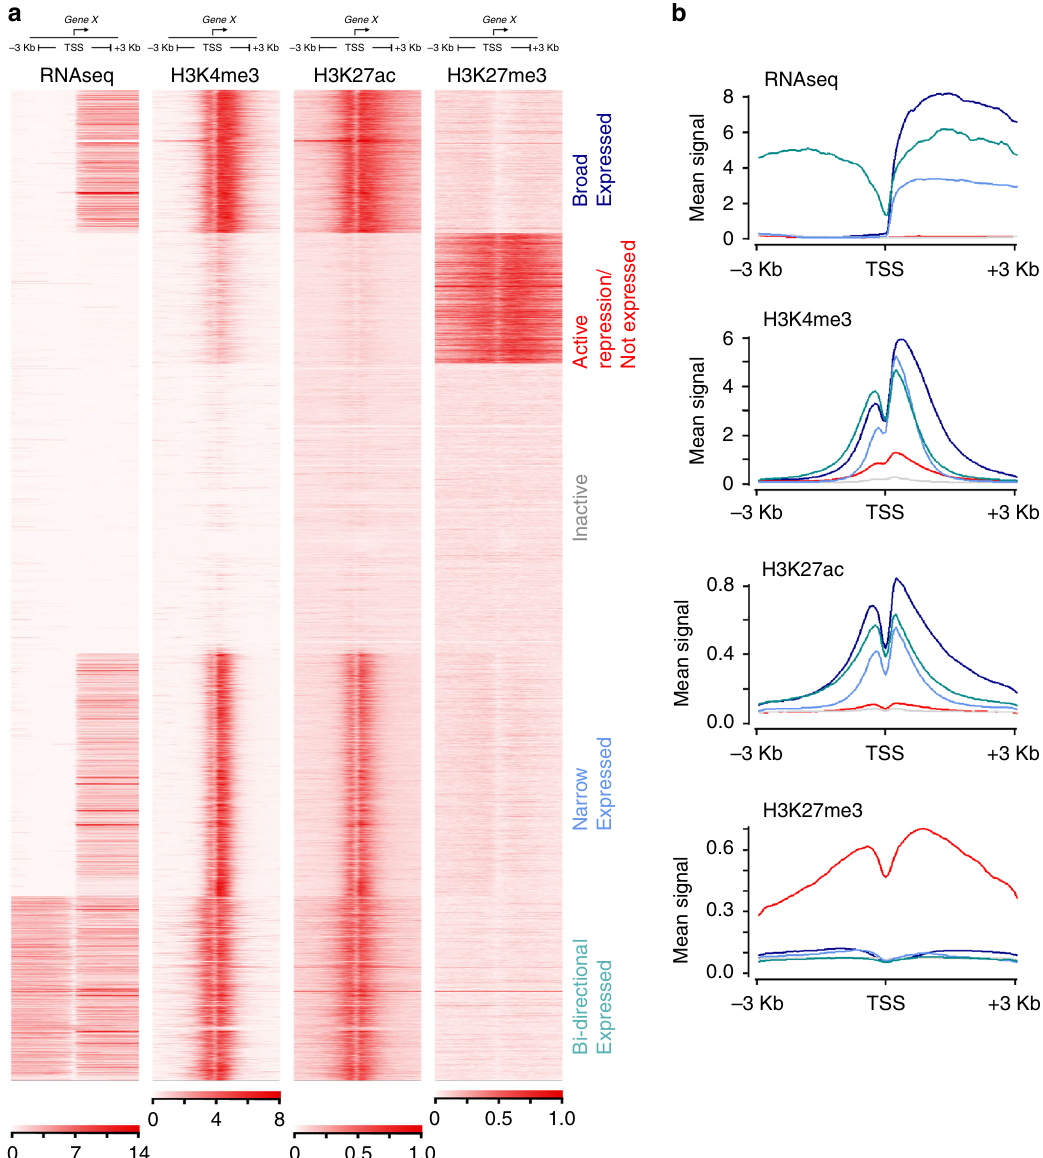
Fig. 2 Classi fi cation of major promoter states. a Clustered heatmaps surrounding the transcriptional start sites (TSS + / − 3 kb) of 19,791 annotated genes. The example shown is for adrenal. One replicate is shown for each data type for simplicity. Replicates across all tissues were near identical. Two minor variations on this pattern were detected in RPE (Supplementary Fig. 2) and the liver, lung and brain (Supplementary Fig. 3). b Mean signal levels for the genes clustered in ( a ). Traces are coloured according to the text colour in ( a ). Broad expressed genes show approximately double the level of transcription and twice the width of H3K4me3 and H3K27ac marks compared with narrow expressed